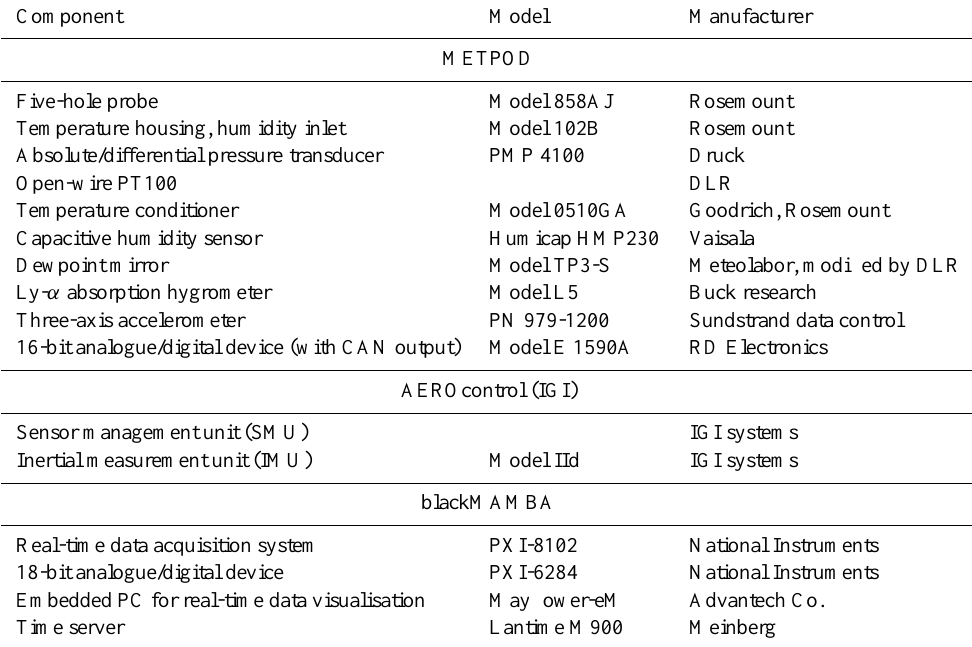
Table 2. List of the main hardware components included in the three major parts of the meteorological sensor system on the Caravan. Component Model Manufacturer METPOD Five-hole probe Model 858AJ Rosemount Temperature housing, humidity inlet Model 102B Rosemount Absolute/differential pressure transducer PMP 4100 Druck Open-wire PT100 DLR Temperature conditioner Model 0510GA Goodrich, Rosemount Capacitive humidity sensor Humicap HMP230 Vaisala Dewpoint mirror Model TP3-S Meteolabor, modified by DLR Ly- α absorption hygrometer Model L5 Buck research Three-axis accelerometer PN 979-1200 Sundstrand data control 16-bit analogue/digital device (with CAN output) Model E 1590A RD Electronics AEROcontrol (IGI) Sensor management unit (SMU) IGI systems Inertial measurement unit (IMU) Model IId IGI systems blackMAMBA Real-time data acquisition system PXI-8102 National Instruments 18-bit analogue/digital device PXI-6284 National Instruments Embedded PC for real-time data visualisation Mayflower-eM Advantech Co. Time server Lantime M900